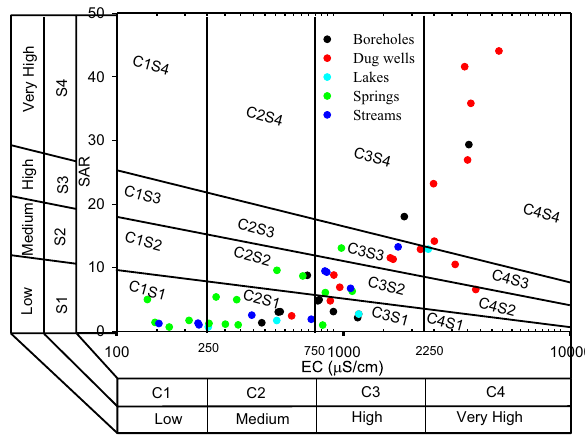
Fig. 22 USSL diagram for classifying suitability of Meru water types for